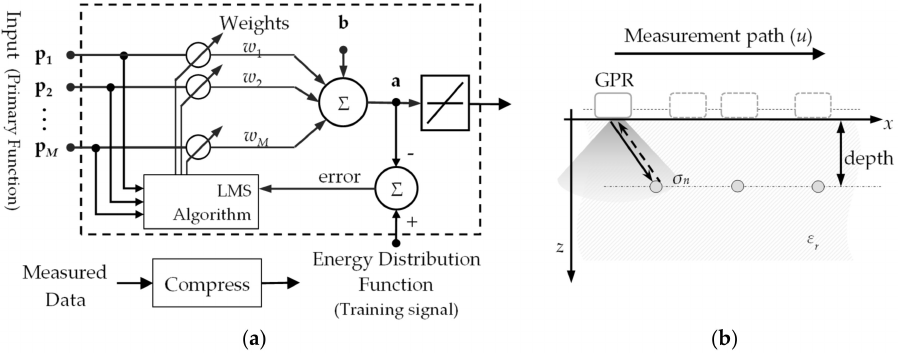
Figure 1. ( a ) Diagram of the neural network based GPR data inversion approach. ( b ) Common-offset and common-depth measurement model. The targets distribute at a same